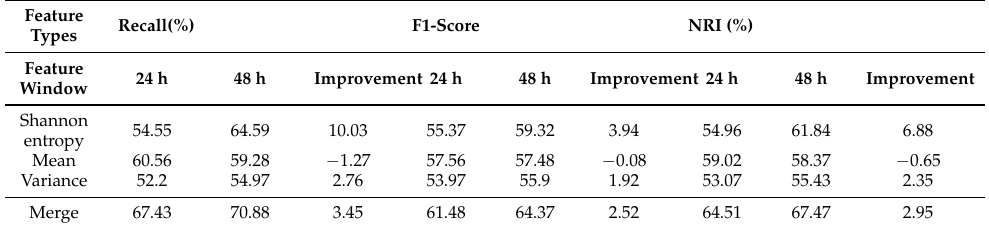
Table 12. Comparison of 24 h and 48 h feature windows on Precision and